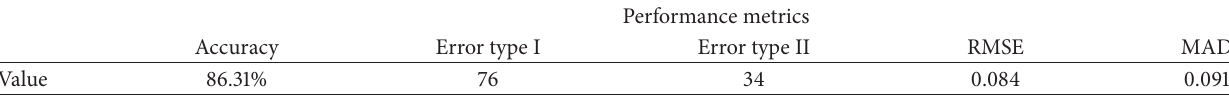
Table 6: Performance metrics of SOM + ANN + Cox hierarchical models.